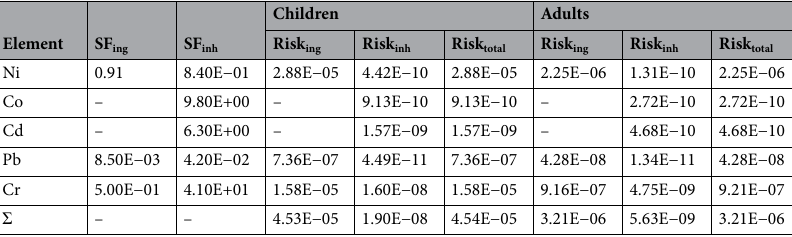
Table 8. The cancer slope and Risk factors calculated for children and